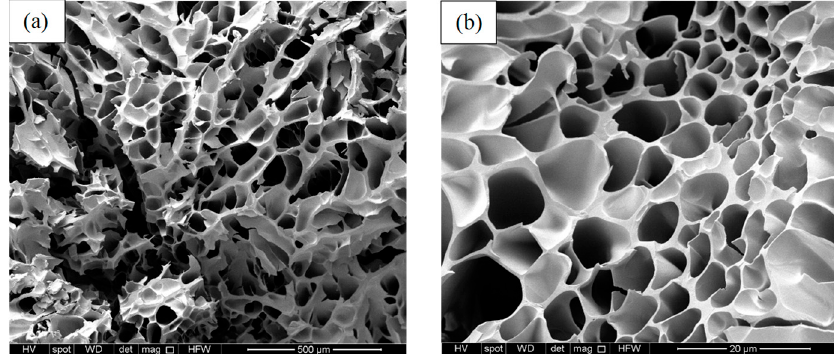
Figure 2. Scanning Electron Microscopy (SEM) images of G2F ( a ) and G2R ( b ).